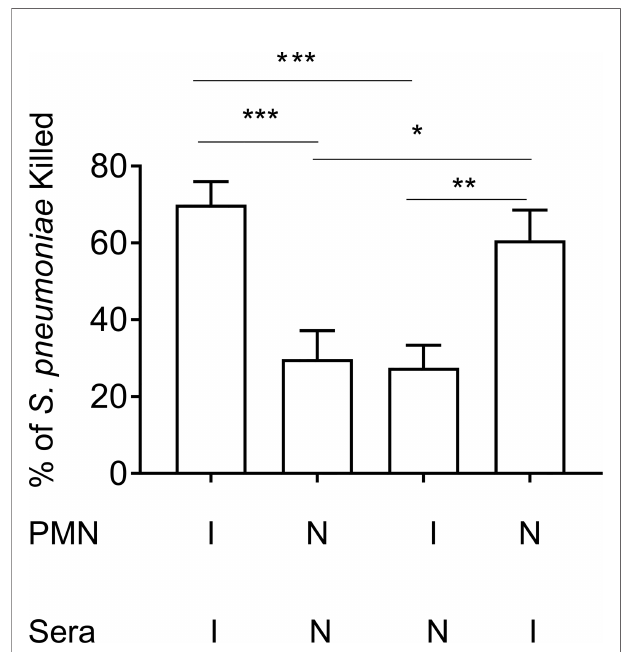
FIGURE 2 | Enhanced opsonophagocytic bacterial killing by PMNs from vaccinated mice is dependent on opsonization by immune sera. PMNs were isolated from the bone marrow of young male C57BL/6 naïve (N) or Prevnar- 13 immunized mice (I) and infected with S. pneumoniae pre-opsonized with either naïve or immune sera. The percentage of bacteria killed was then calculated with respect to a no PMN control under the same treatment conditions. Data shown are pooled from three separate experiments (n = 3 biological replicates) where each condition was tested in triplicate (n = 3 technical replicates) per experiment. *, denotes signi fi cance as calculated by One-way ANOVA followed by Tukey ’ s multiple comparisons test. * denotes p < 0.05, ** denotes p < 0.01, and *** denotes p <